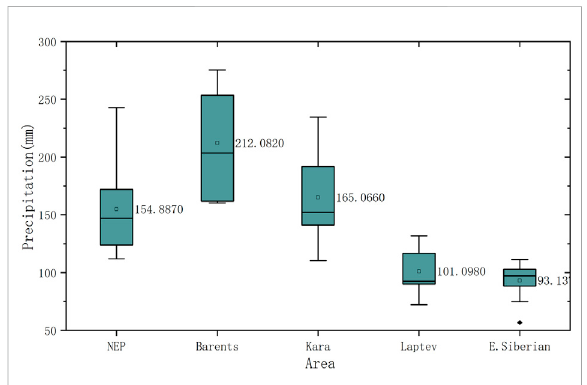
FIGURE 2 The average precipitation from May to December in the Northeast Passage, with corresponding individual averages for the Barents Sea, Kara Sea, Laptev Sea, and East Siberian